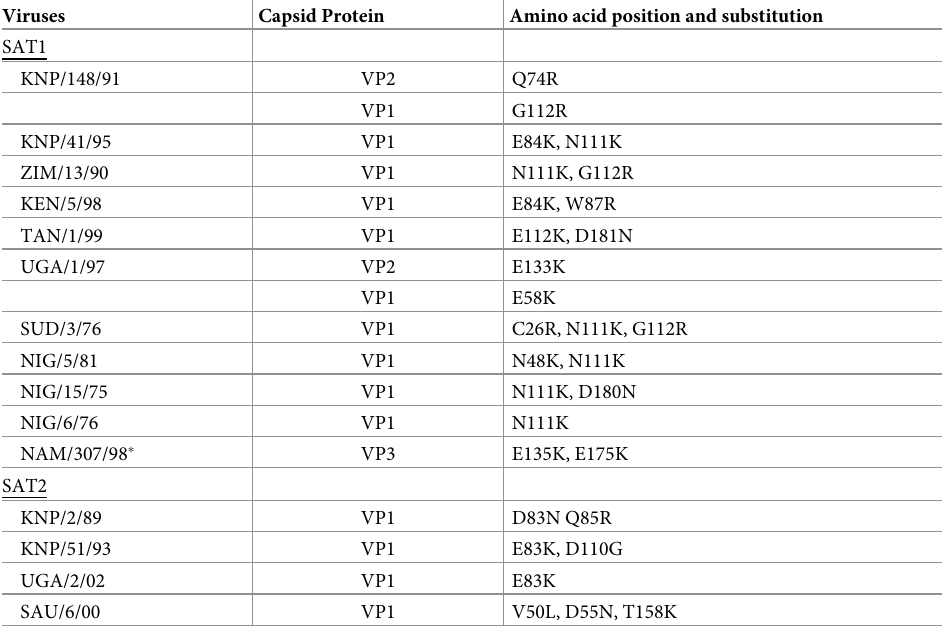
Table 2. Summary of the amino acid substitutions causing a change in the charge in the outer capsid proteins of serially passaged SAT1 and SAT2